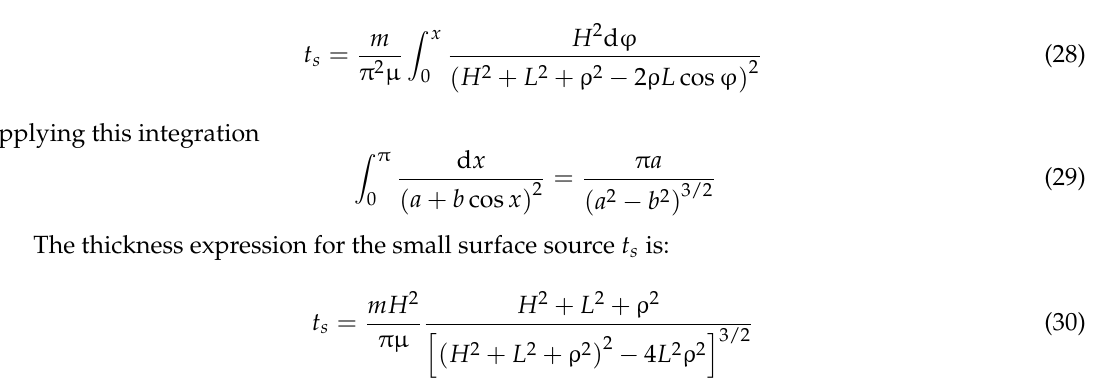
Figure 9. Distribution of the thin film thickness on the spherical surface substrate holder.